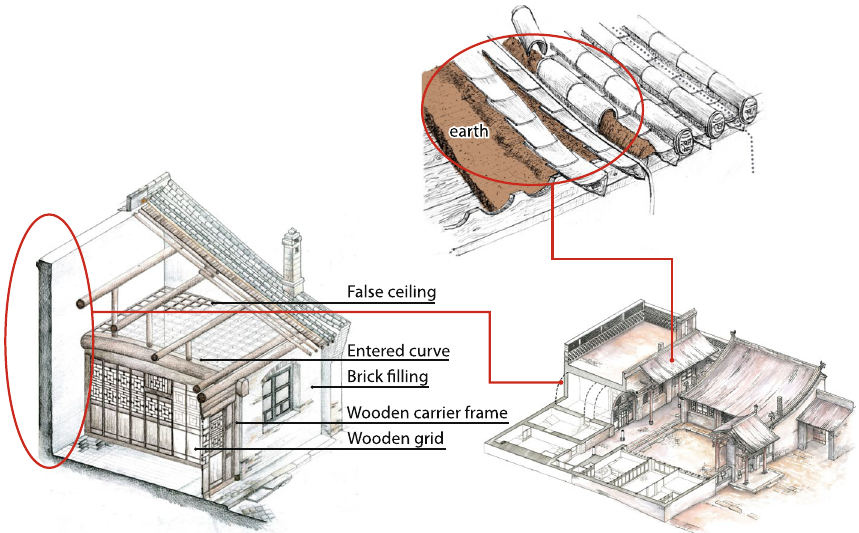
Fig. 12 Earthen material and the detailed treatment to prevent rainwater in Shanxi residential architectures (Source: Tongji University and Ecole de Chaillot